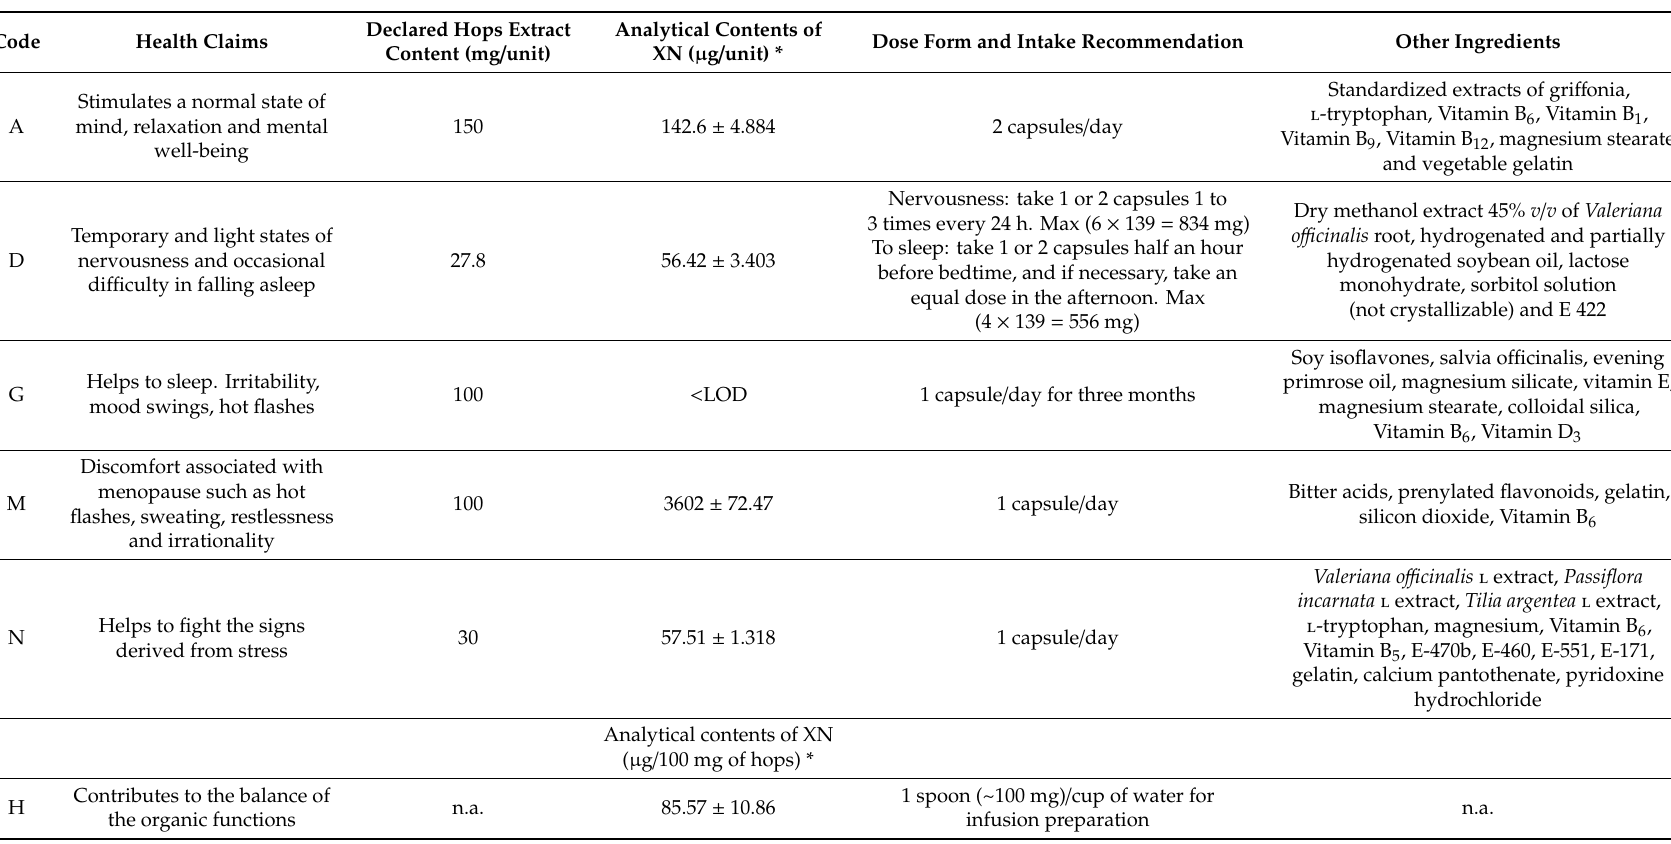
Table 2. Description of the composition and analytical concentration of XN detected in food supplements (A, D, G, M and N) and hops